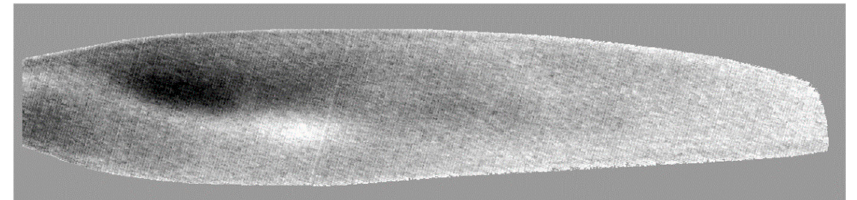
Figure 1. DIT Image of rotor R18x6 at f 3 = 100